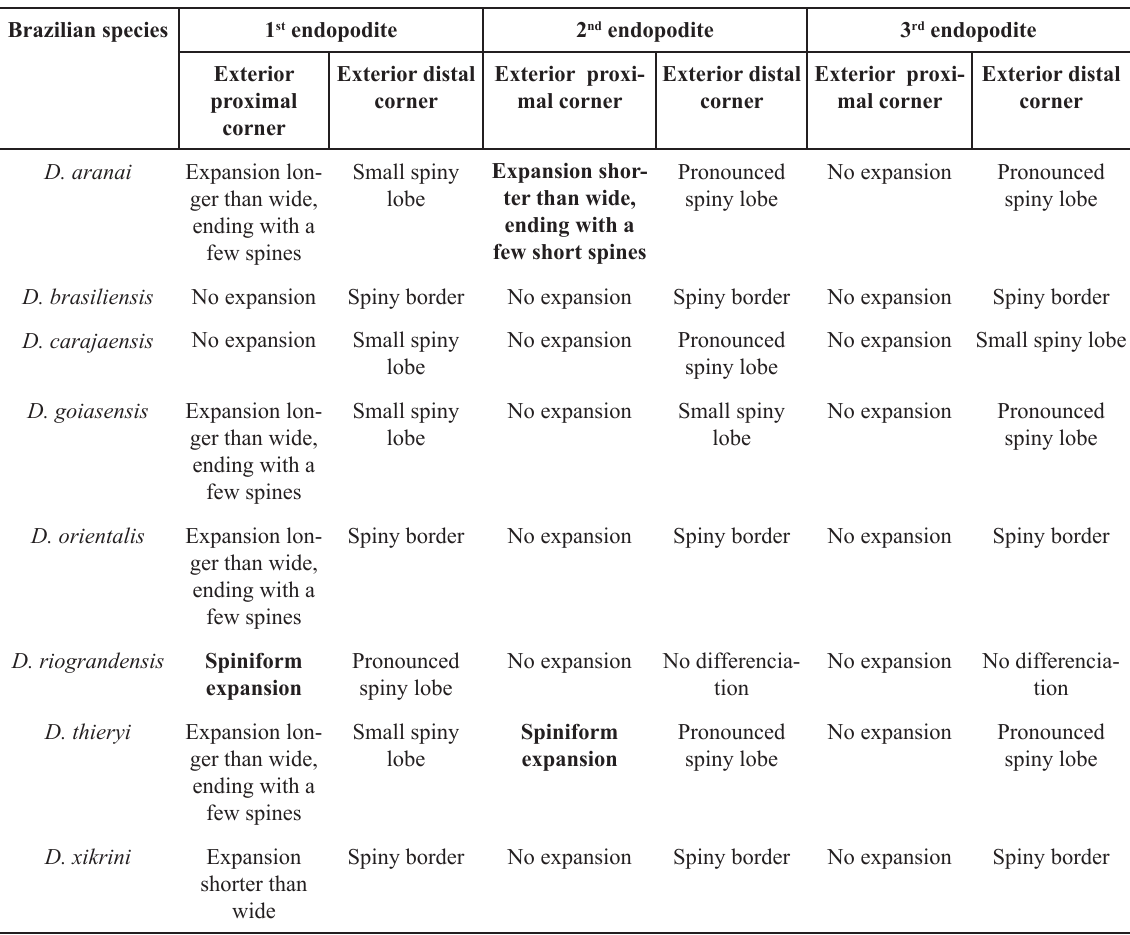
Table 3. Endopodite richness in Brazilian Dendrocephalus Daday, 1908. The bold characters correspond to characters allowing a direct determination of species in